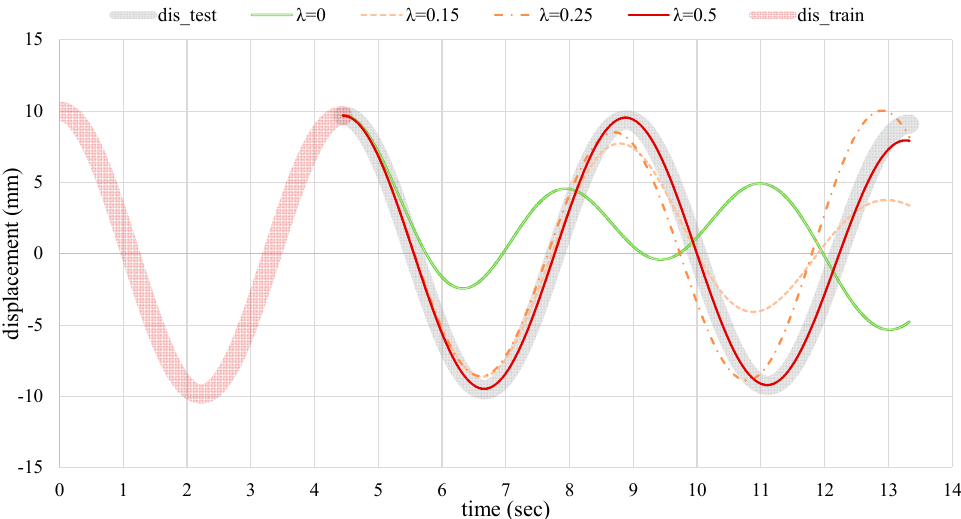
Figure 12. Displacement estimation of the PINN for various λ and the ANN with λ = 0 during the test period.